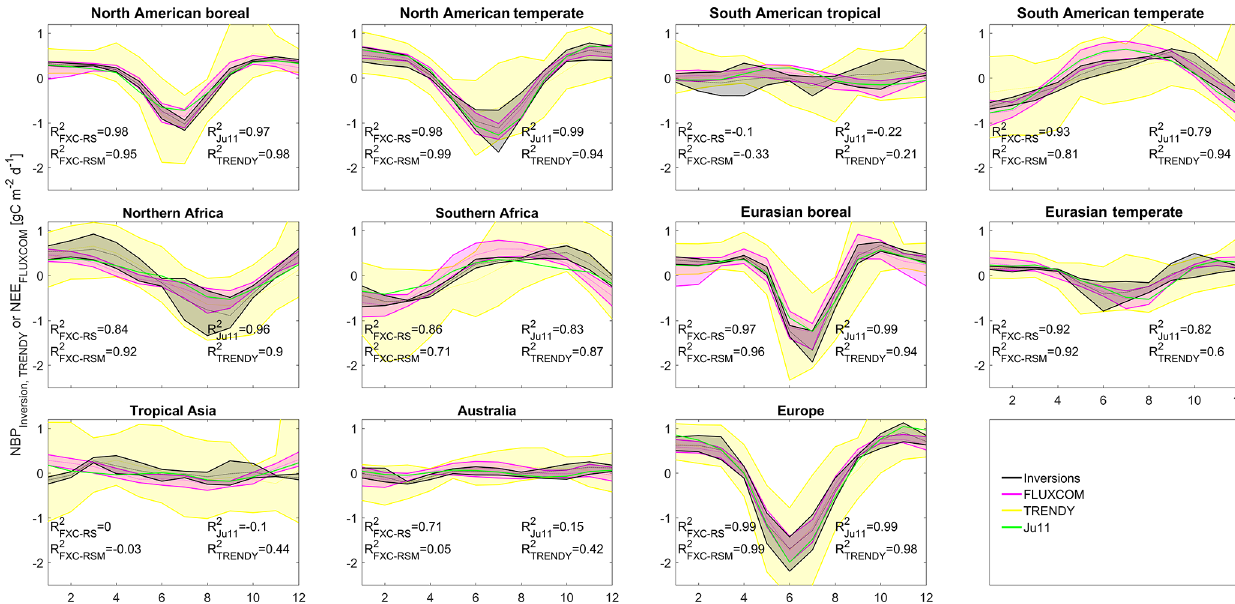
Figure 7. Mean seasonal variations in net land carbon release for the period 2008–2010 over TRANSCOM regions. For inversions and TRENDY, NBP was plotted, and for FLUXCOM, NEE was plotted. Please note that the region-specific mean was removed for each data set. Shading indicates the range of estimates (maximum – minimum). The FLUXCOM range is based on the union of RS and RS + METEO ensemble members. R 2 values were calculated with the mean of the inversions. The FLUXCOM RS and RS + METEO refer to the ensemble products (median), while those for TRENDY refer to the model